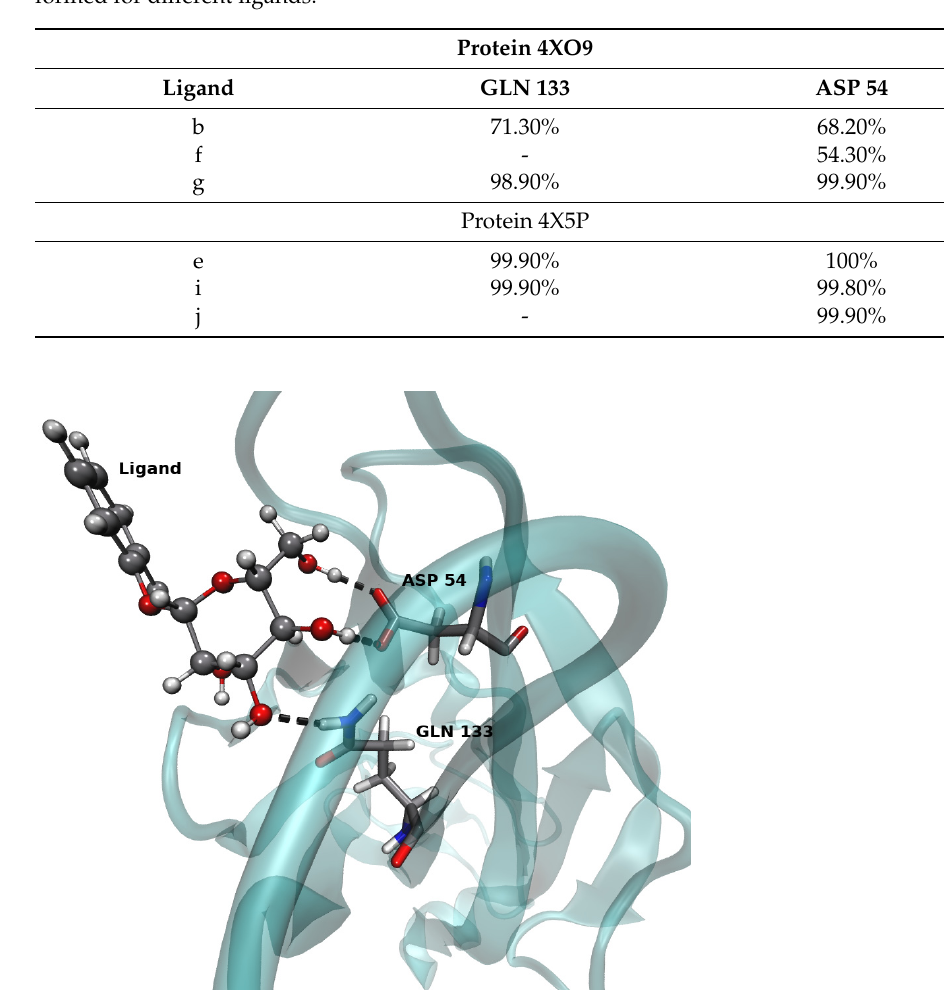
Figure 2. Visualization of the hydrogen bonds between ASP 54, GLN 133 residues, and ligand e.